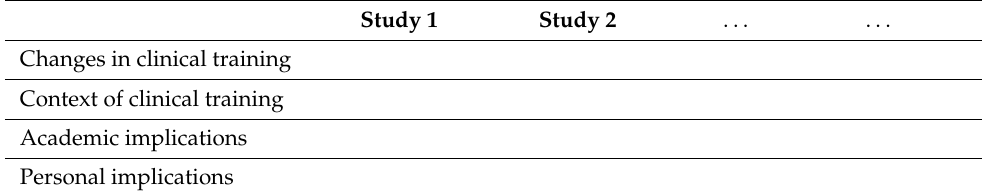
Table 3. Data collection in tabular